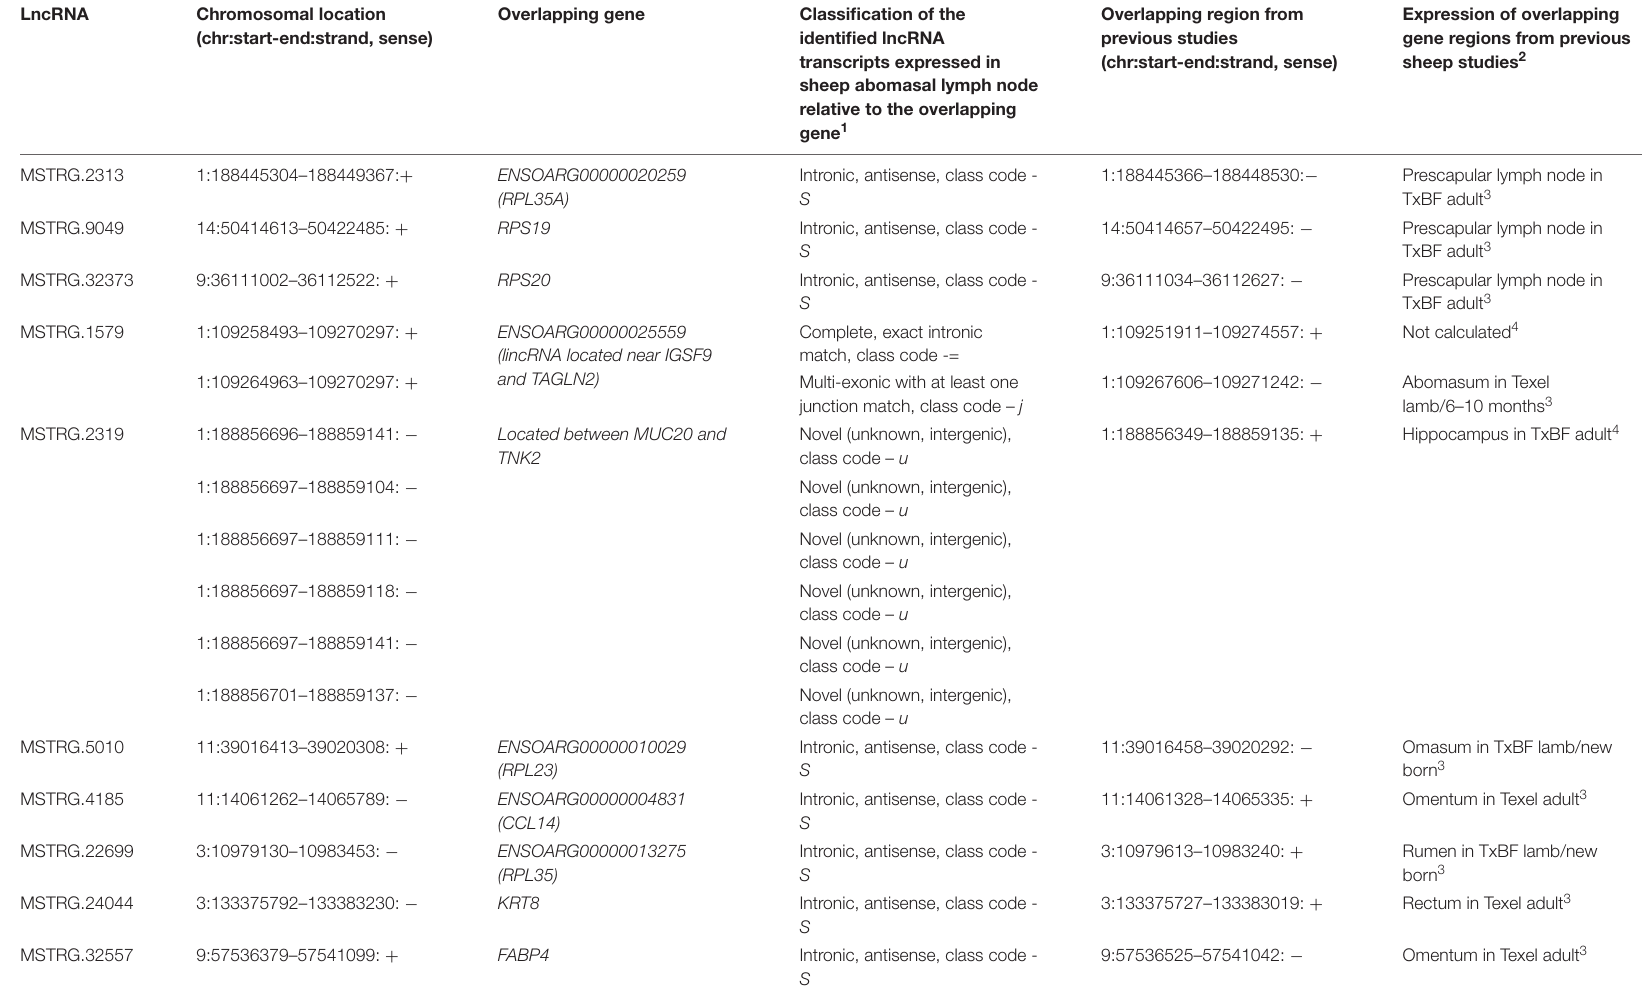
Overlapping gene Classification of the